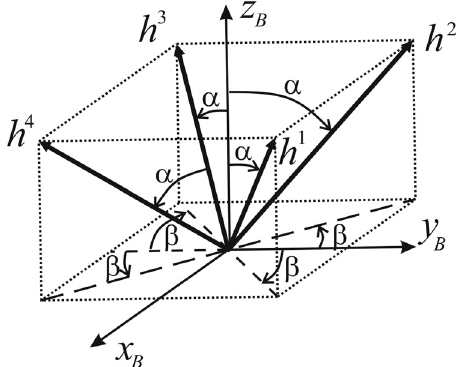
Table 1: Parameters of the FE model of the